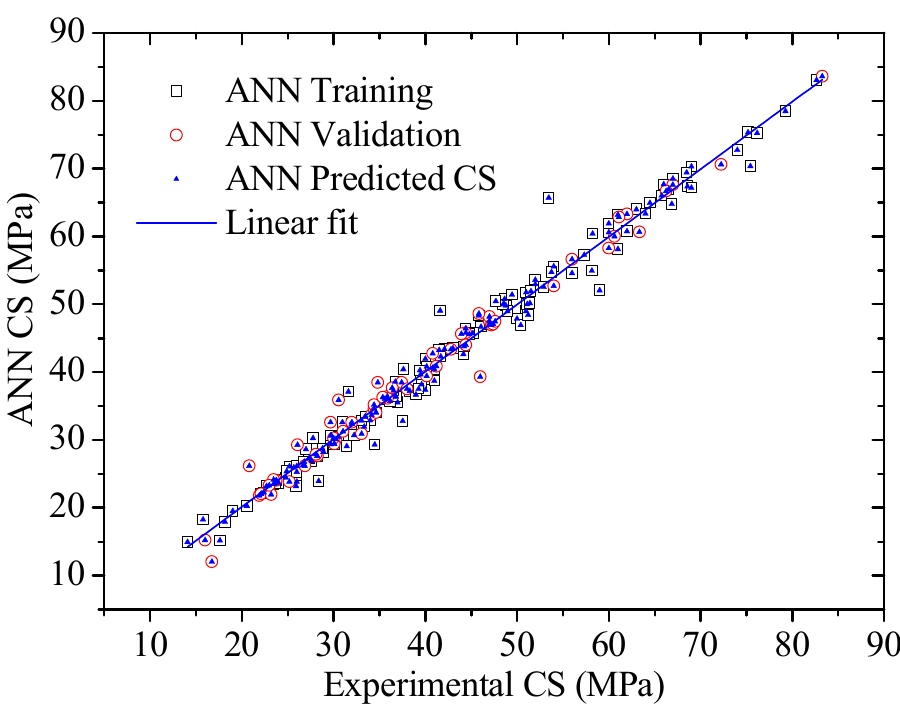
Figure 4. ANN: training, validation, and testing.